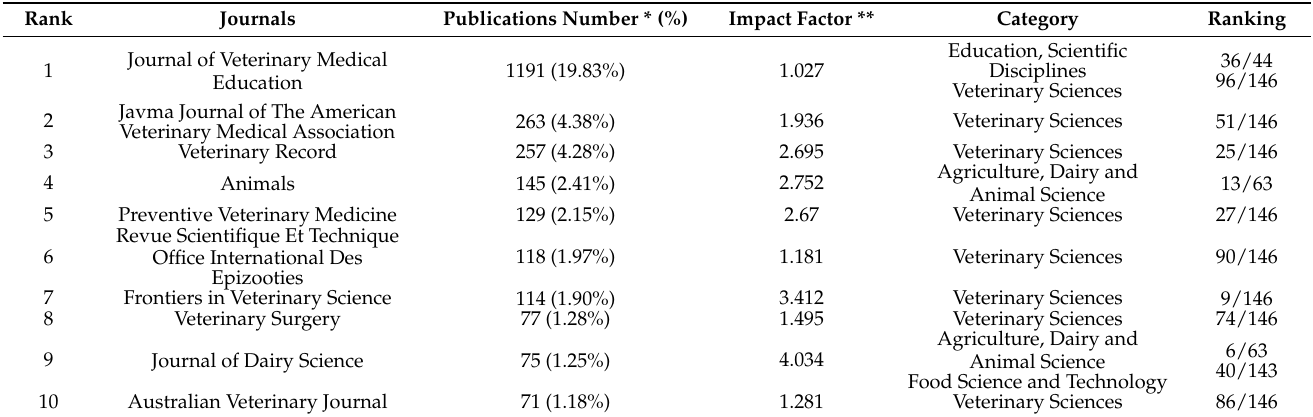
Table 3. The top 10 productive journals for veterinary education publications (VEPs) from 2000 to 2021.